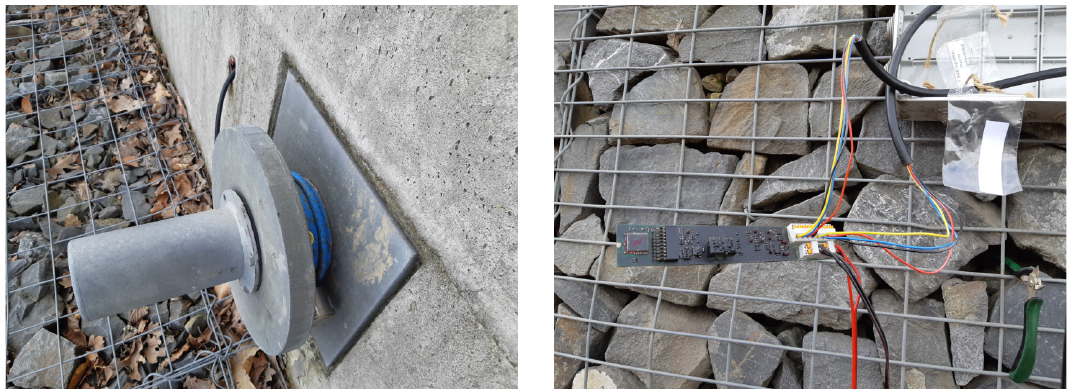
Figure 14. Load anchor cell sensor ( left ), load anchor cell wireless node outside the plastic tube ( right ).